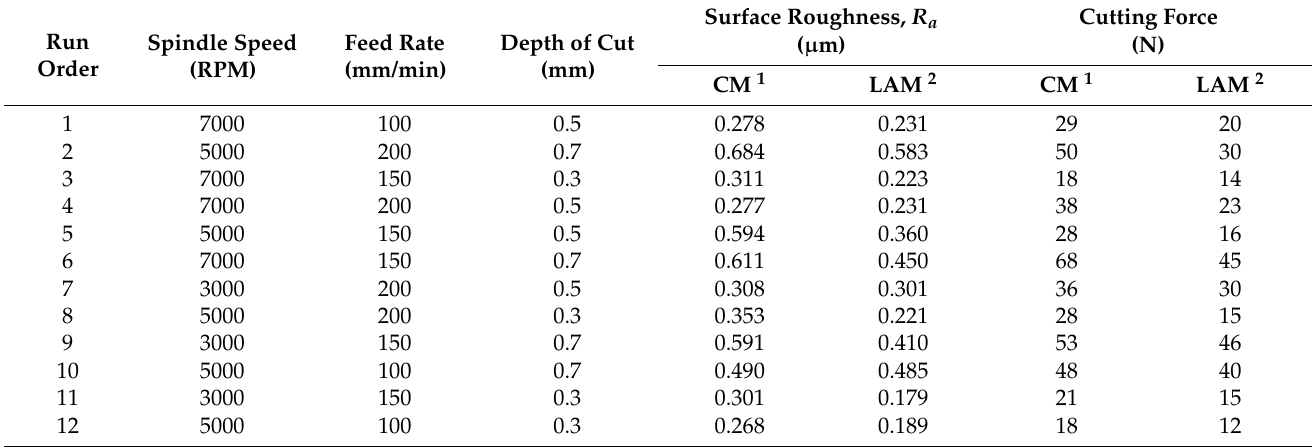
Table 4. Experimental order and